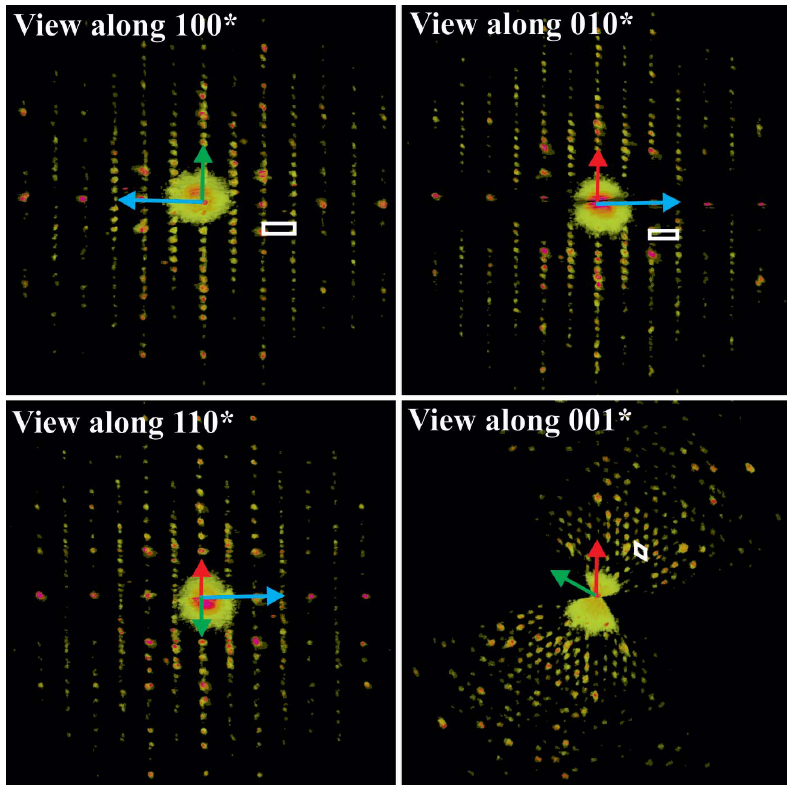
Figure 3 Projection of 3D ED reconstructed data taken from a single nanocrystal. ( a ) The view along 100*, ( b ) the view along 010*, ( c ) the view along 110* and ( d ) the view along 001*. Cell edges are sketched in white. Red arrows represent the projection of a* green arrows represent the projection of b* and blue arrows represent the projection of c* . Note that these are projections are along a 3D diffraction volume and are not conventional 2D oriented ED